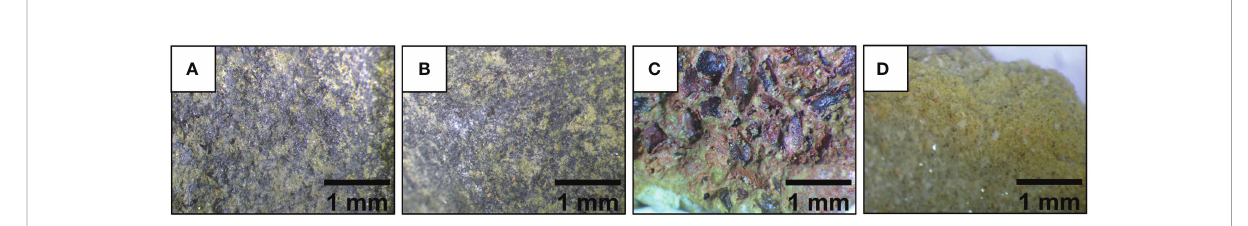
FIGURE 2 Microscopic view of the different surface texture of the tested gravel: (A) small basalt, (B) large basalt, (C) crushed laterite, and (D)